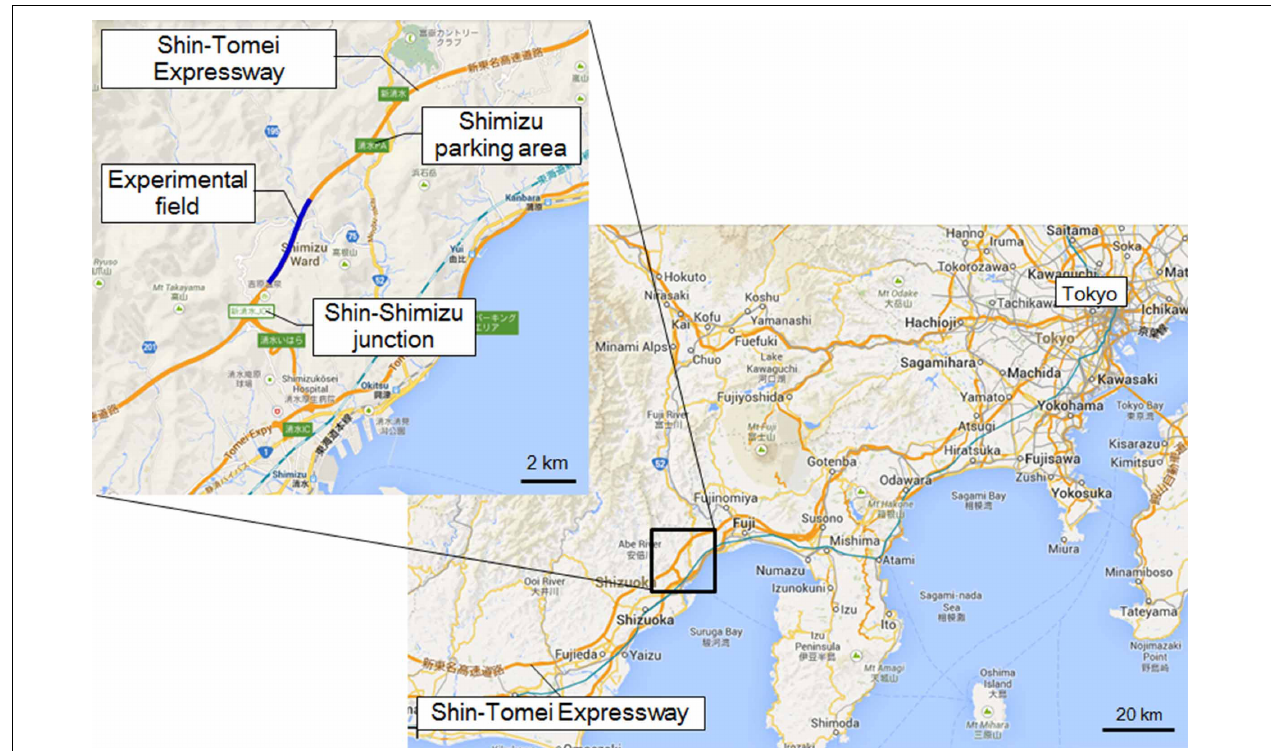
FIGURE 1 | Location of the experiment. Location of the Shin Tomei Expressway, showing the experimental